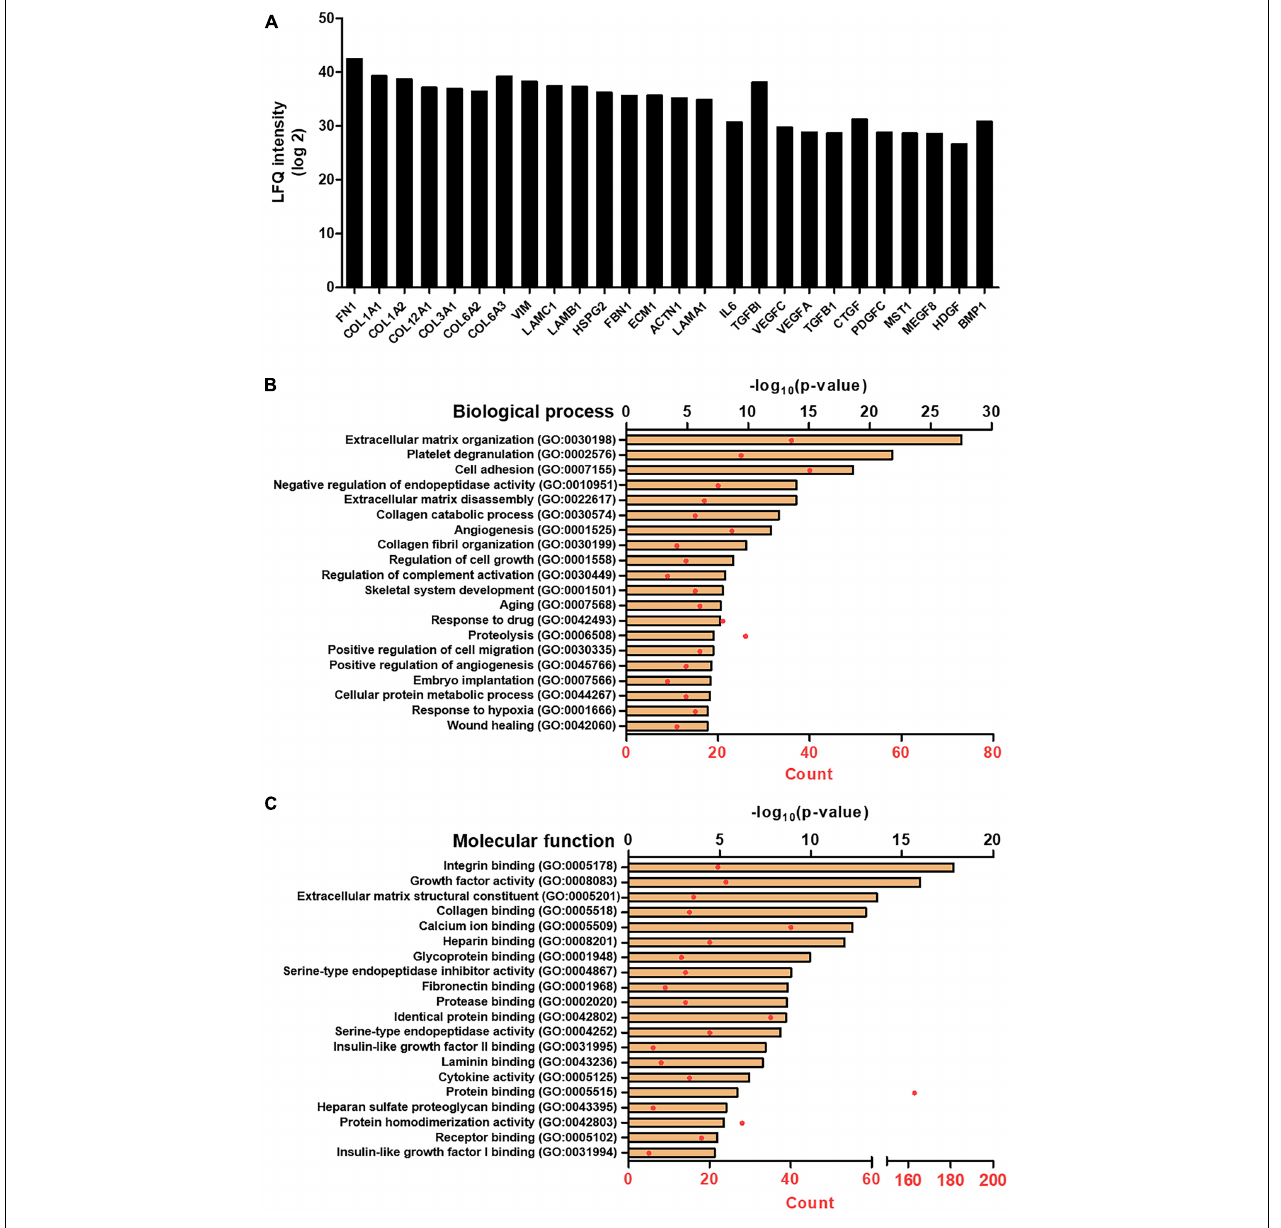
FIGURE 1 | Proteomic analysis of SF. (A) LFQ intensity of representative extracellular matrix protein and growth factors, measured by LC/MS-MS. Gene ontology (GO) analysis representing the top 20 GO terms and its number of enrichment in (B) biological process and (C) molecular function.